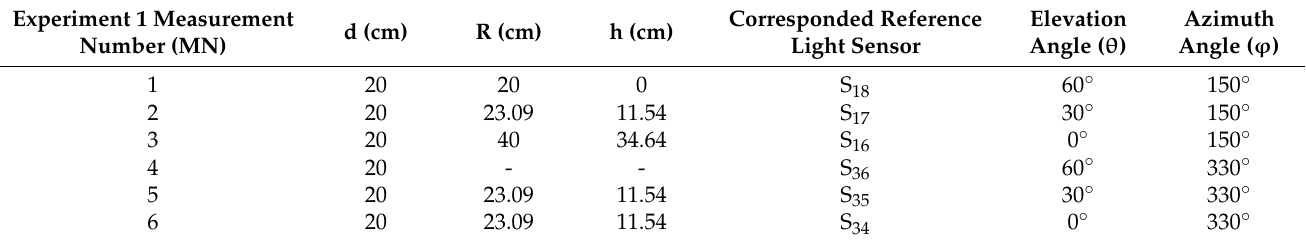
Table 1. Parameters of Measurements for Experiment 1.